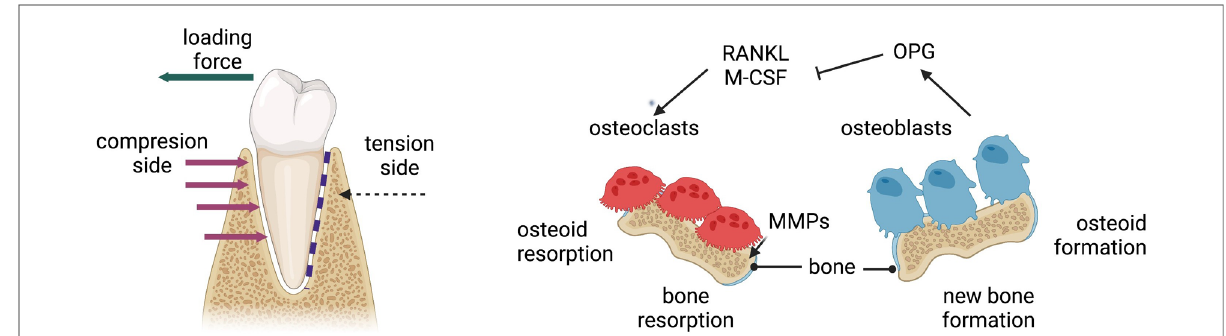
FIGURE 2 Mechanism of orthodontic tooth movement due to compression and tension generated from orthodontic loading. MMPs, matrix metalloproteinases; OPG, osteoprotegrin; M-CSF, macrophage colony-stimulating factor; RANKL, receptor activator of nuclear factor kappa- Β ligand. Figure created with